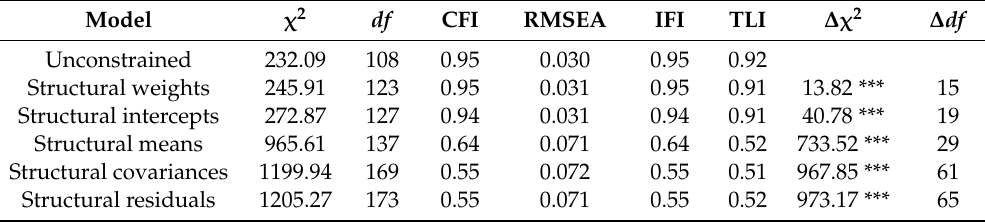
Figure 1. Nursing Sector-Specific Model on Occupational Turnover Intention for younger versus older nurses; standardized estimates. Table 4. Goodness-of-fit Indices for Alternative